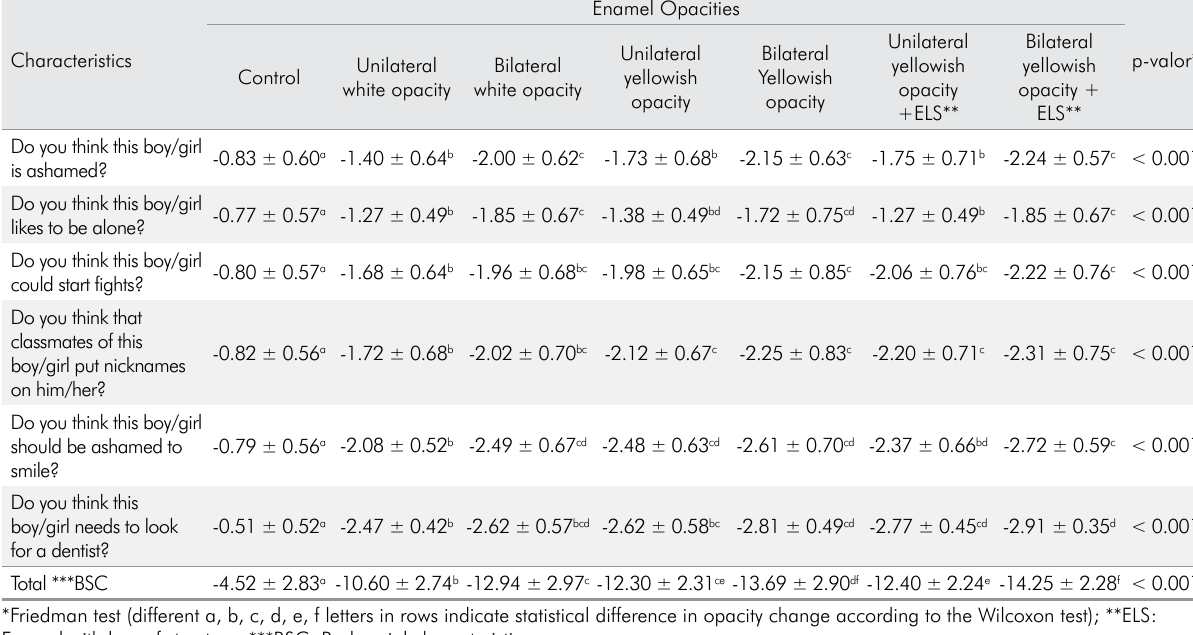
Table 5. Scores (mean ± standard deviation and median ± interquartile range) for negative social judgment according to the individual’s perception of enamel